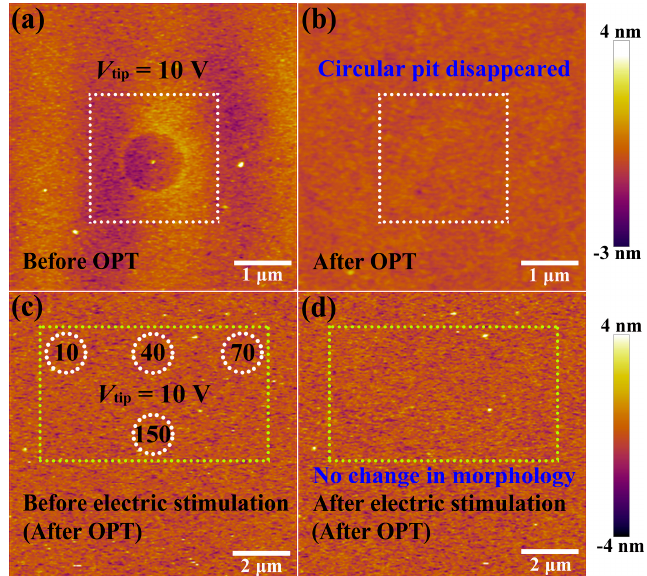
Figure 3. ( a ) Topographic image of the as-deposited HfO x nanofilm with a circular pit created by electrical stimuli before oxygen plasma treatment (OPT) and ( b ) the circular pit disappeared after OPT (see the the white dashed box). After OPT, ( c ) topographic image before applying electrical stimuli (white dotted circles indicate the locations where voltage sweepings will be performed) and ( d ) no morphological changes after applying electrical stimuli (see the the yellow dashed box).